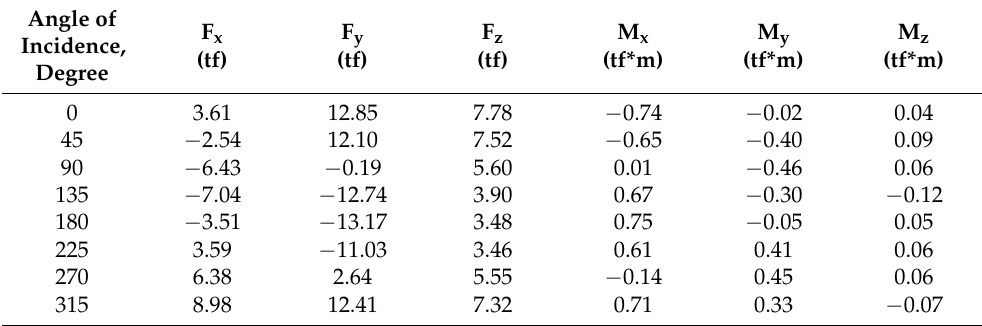
Table 2. Forces Fx, Fy, Fz (tf), bending torques Mx, My, torque Mz (tf*m) for the closed aeroelastic model, Option (1111). Angle